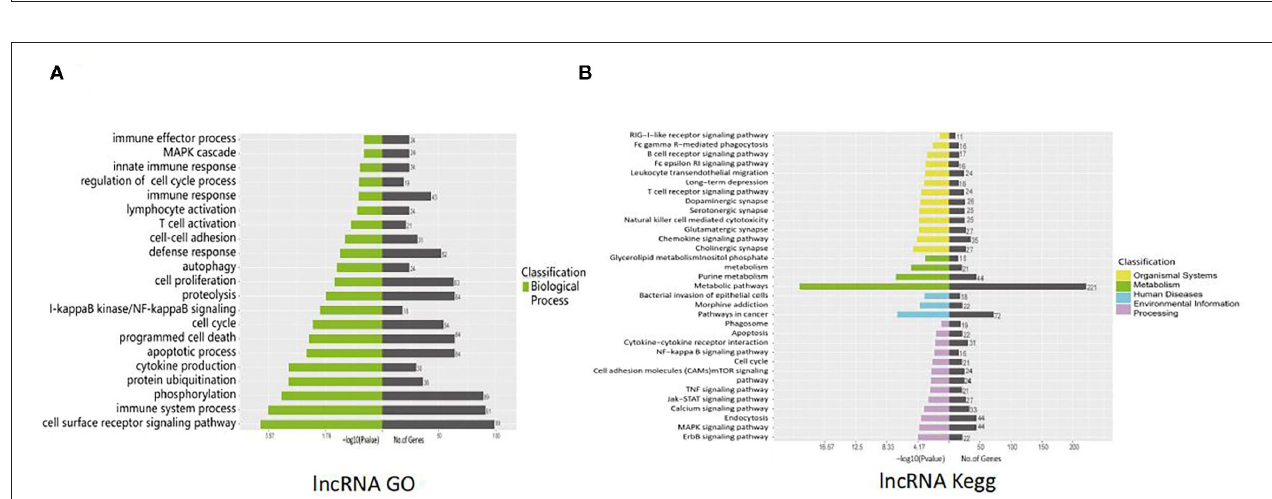
FIGURE 2 | Genetic features of mRNAs, annotated lncRNAs, and novel lncRNAs. (A) Density map of the length distribution of mRNAs, annotated lncRNAs, and novel lncRNAs identified by RNA-seq analysis. (B) Distribution of the number of exons in mRNAs, annotated lncRNAs, and novel lncRNAs identified by RNA-seq. (C) Boxplot analysis of the expression features of mRNAs, annotated lncRNAs, and novel lncRNAs.